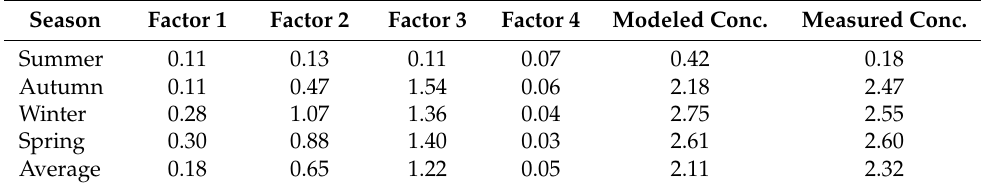
Table 6. Measured and modeled concentrations of Σ BaPeq in PM 2.5 (unit: ng/m 3 ). Season Factor 1 Factor 2 Factor 3 Factor 4 Modeled Conc. Measured Conc. Summer 0.11 0.13 0.11 0.07 0.42 0.18 Autumn 0.11 0.47 1.54 0.06 2.18 Winter 0.28 Spring 0.30